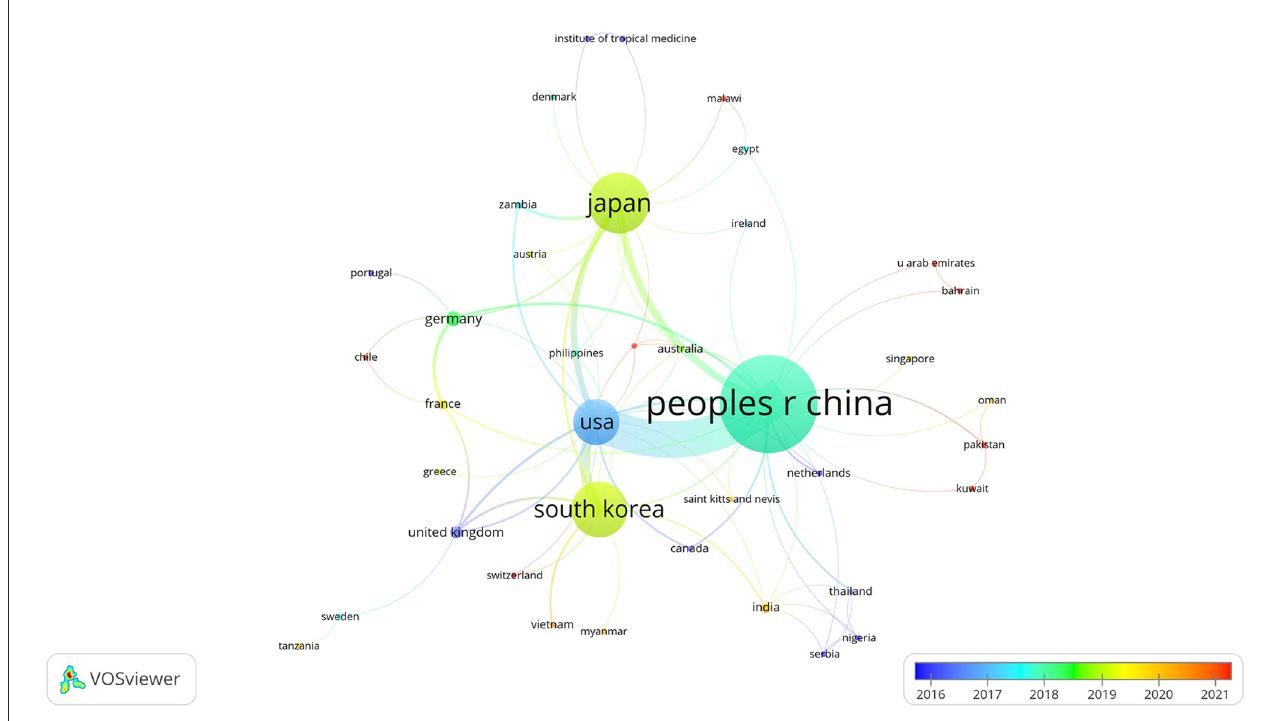
FIGURE2 Cooperation map of countries.